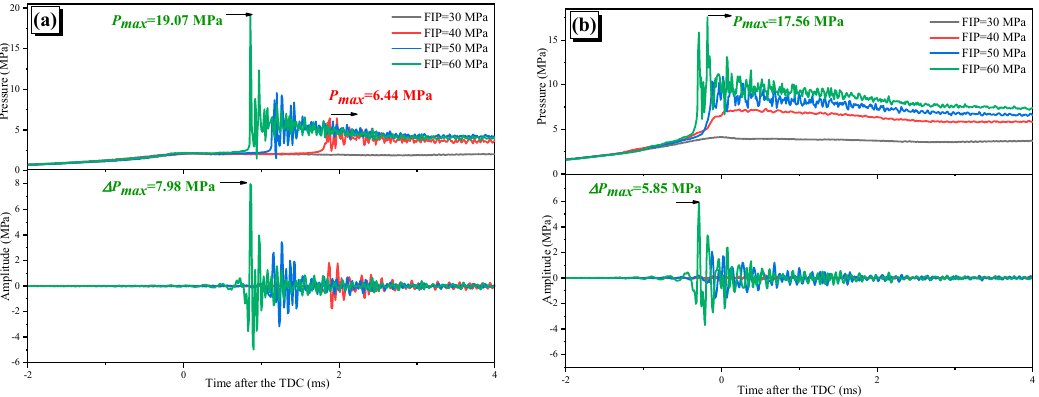
Figure 6. In-cylinder pressure and pressure oscillations at: ( a ) T c = 930.8 K, P c = 2.14 MPa, ∆ t = 1.5 ms; ( b ) T c = 921.4 K, P c = 4.13 MPa, ∆ t = 1.5 ms.